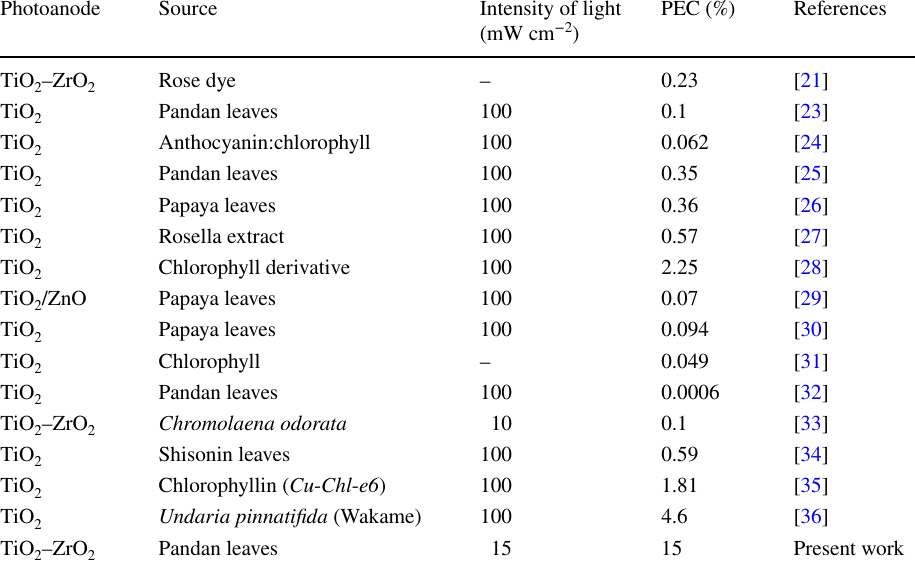
Table 1 Summary of photovoltaic performance of chlorophyll dye-sensitized with various photoanodes for DSSC